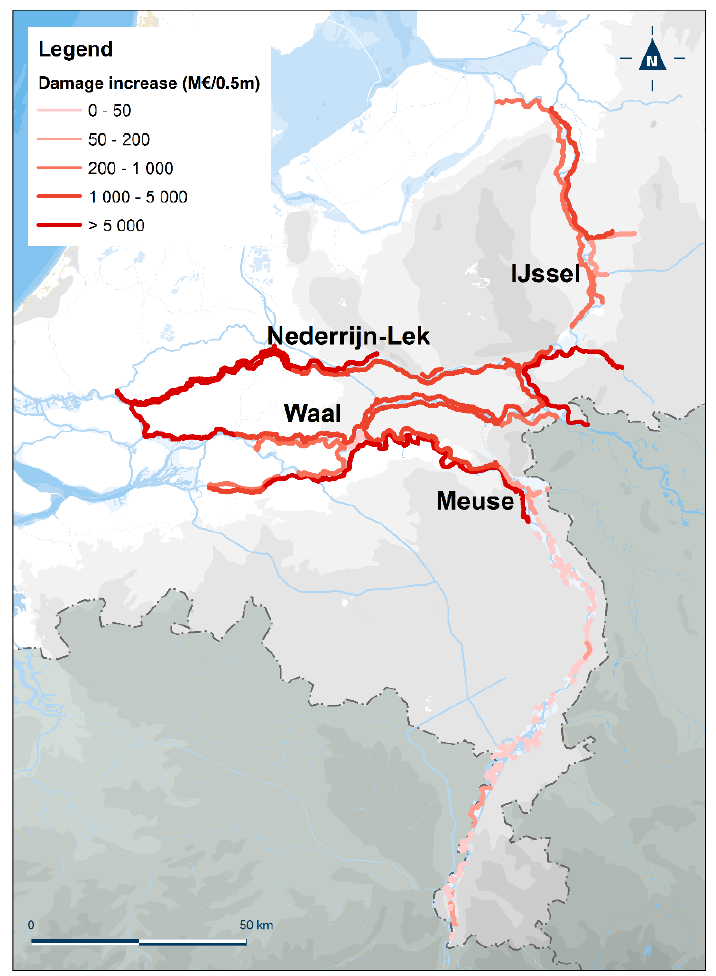
Figure 5. Increase in economic damage resulting from 0.5 m higher river flood levels in the river.